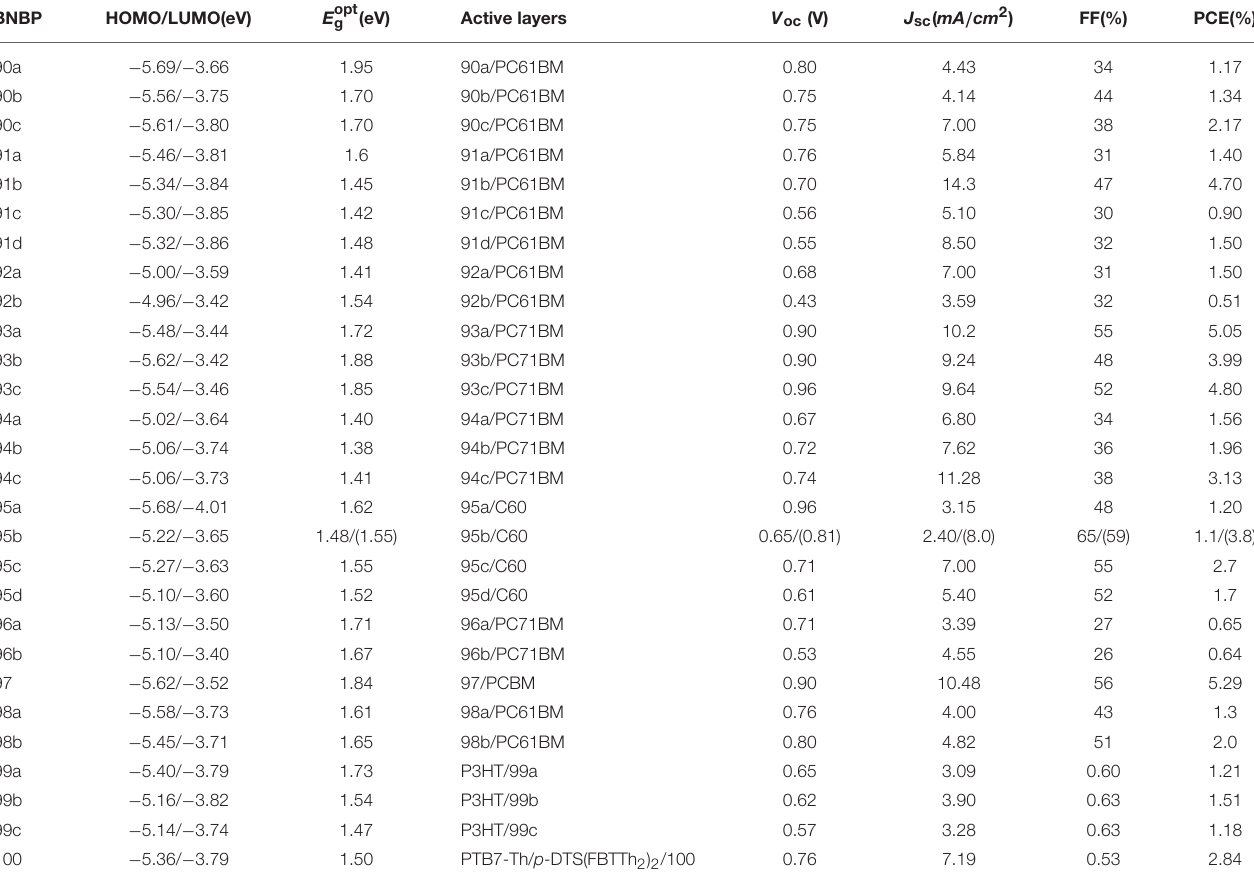
TABLE 2 | Optoelectronic and photovoltaic parameters for BODIPY-based